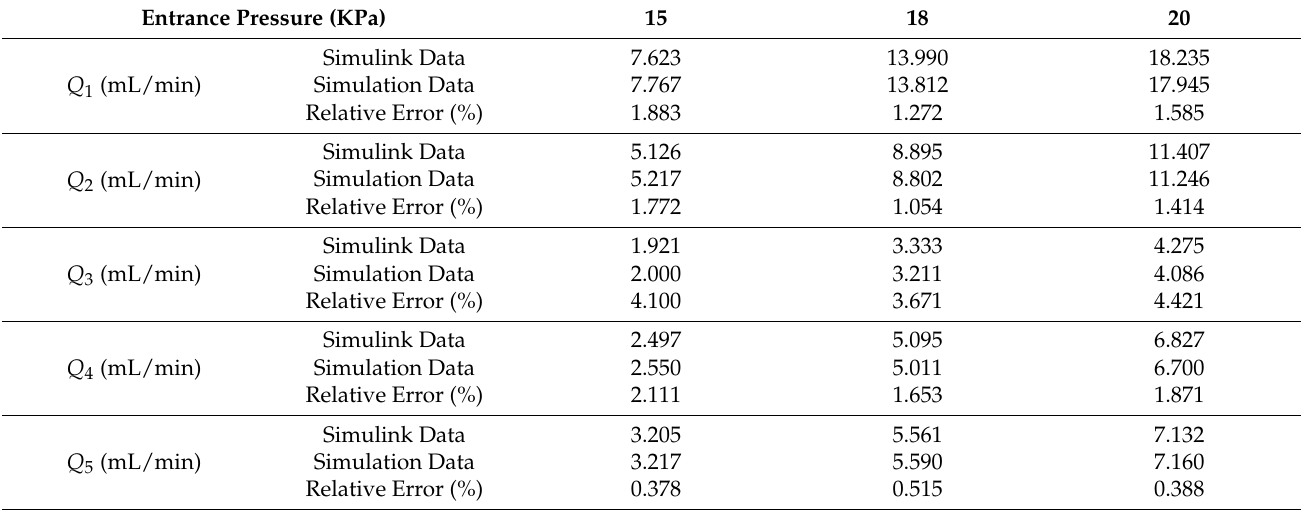
Table 2. Model Simulation and Simulink calculation results under different pressures.